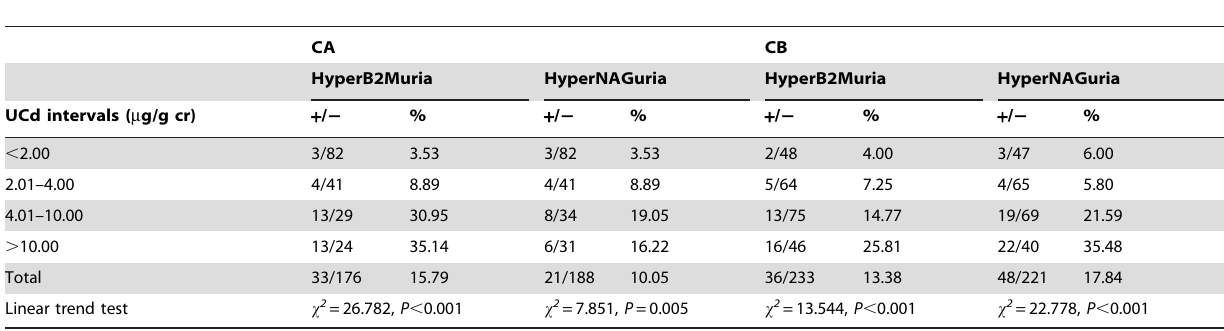
Table 3. Prevalence of hyperB2Muria and hyperNAGuria corresponding to UCd intervals among subjects in CA and CB a .